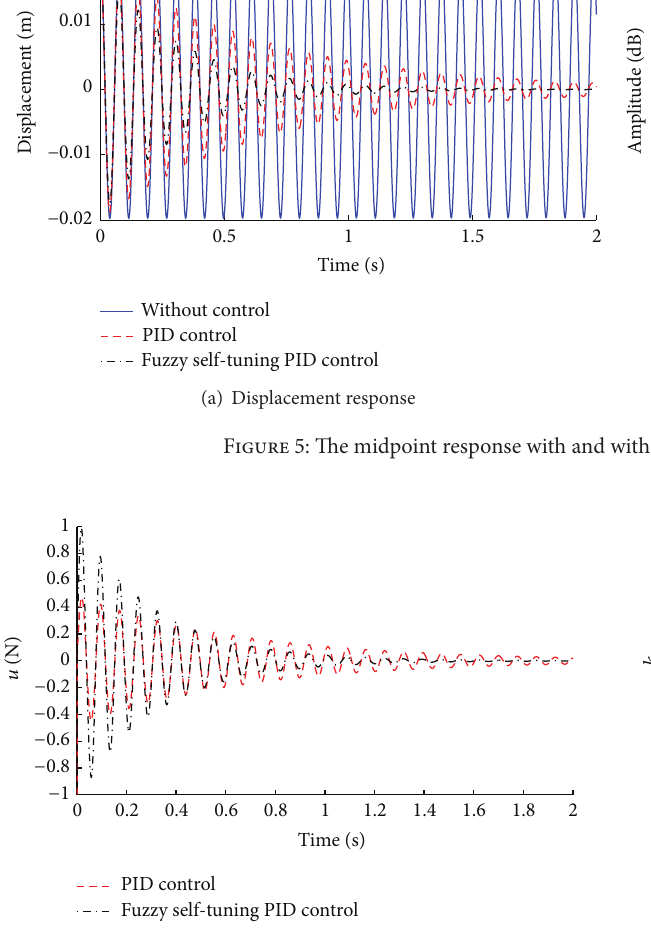
Figure 6: The control forces in initial displacement field.